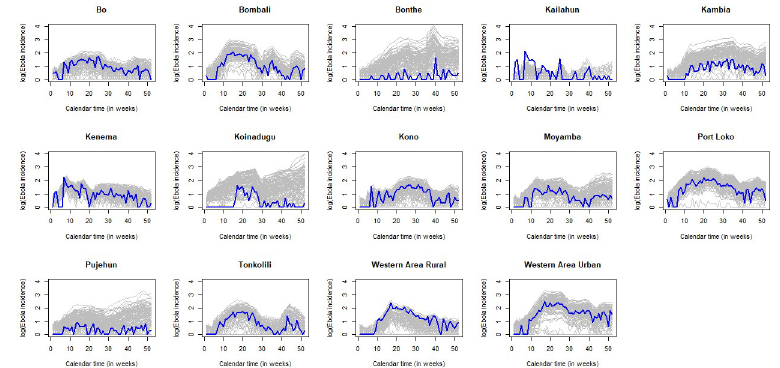
Fig 4. Stochastic simulation of the incidence data obtained from the joint posterior distributions of ( β j ( t ), 1/ % , 1/ γ , E (0), I (0)). The simulated data and the observed incidence data are displayed on the logarithm scale. The solid blue curve represents the observed incidence data and the solid gray curves represent the simulated incidence data.